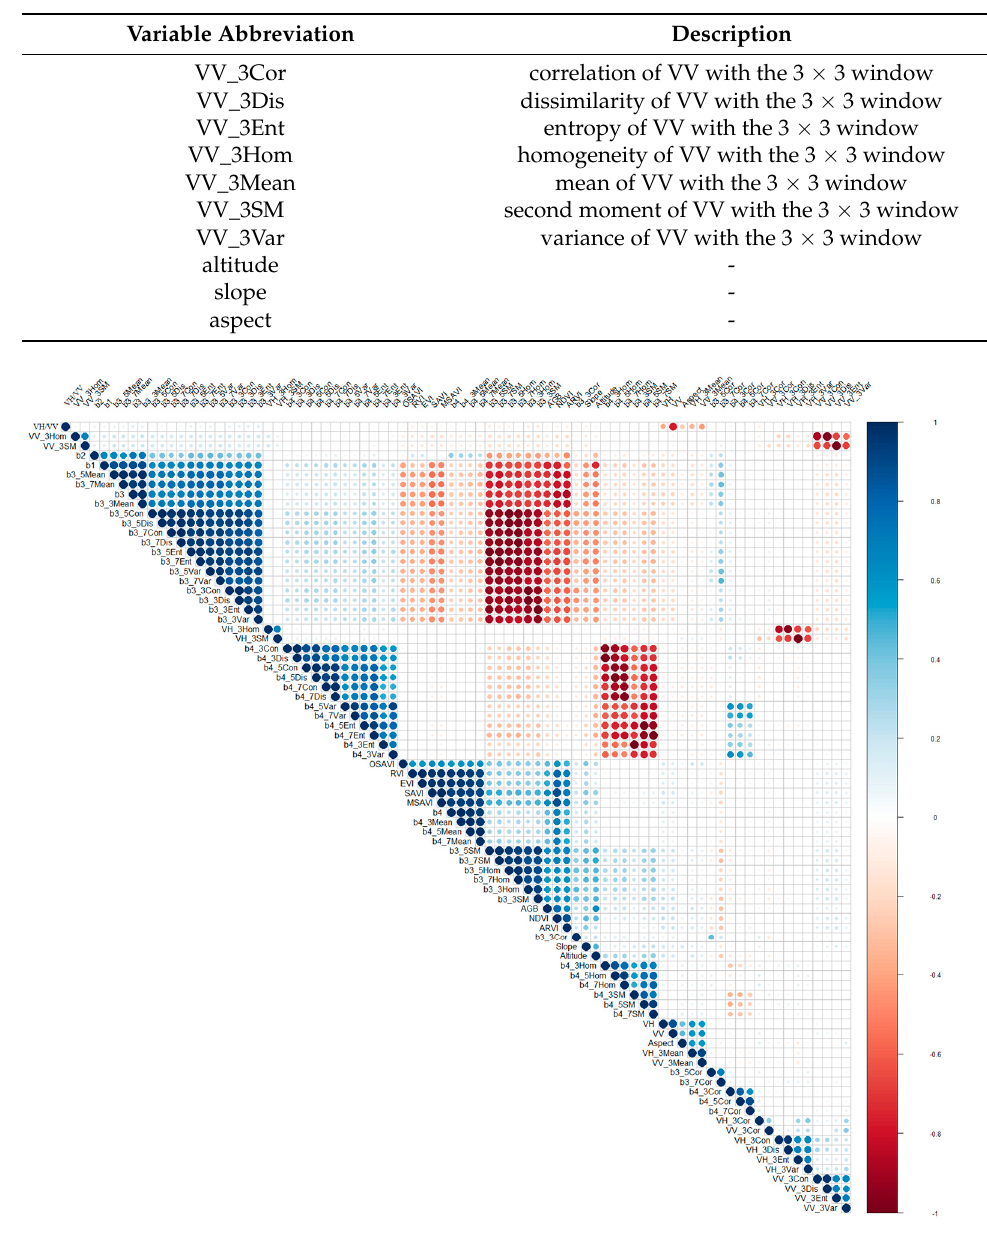
Figure A1. Correlation coefficients between the forest AGB and the explanatory variables. Table A1. Variable abbreviation in correlation analysis.